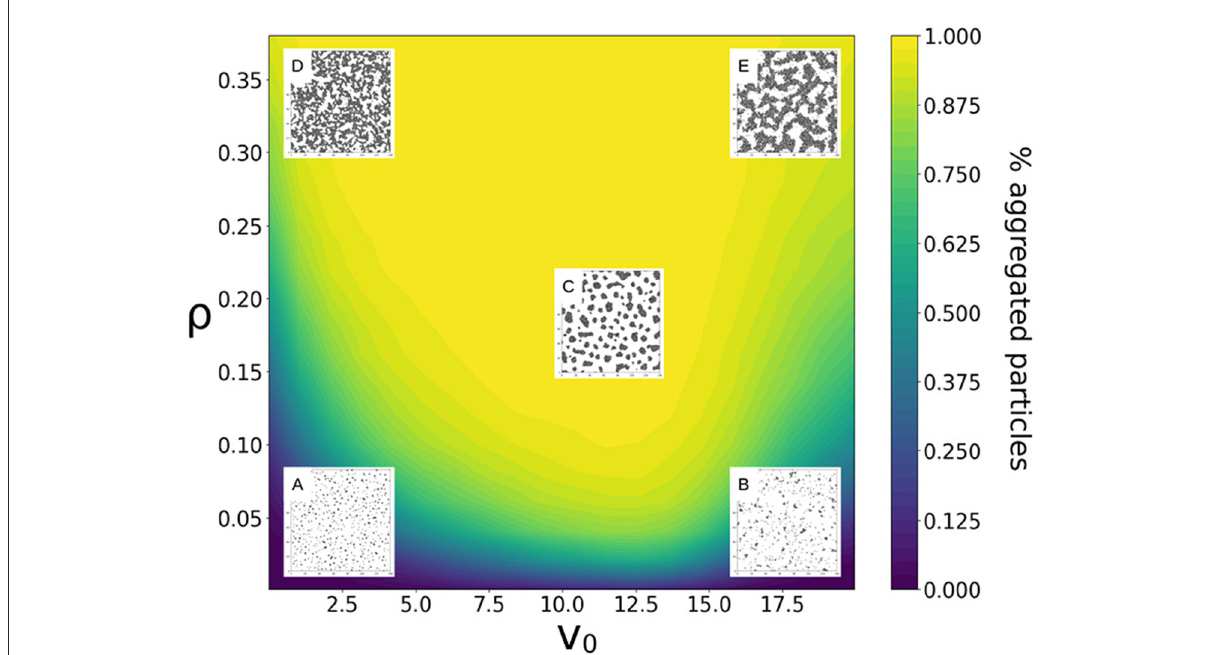
FIGURE2 Finite-time state diagram for a population of identical particles of speed v 0 and packing fraction ρ . The fraction of aggregated particles at the end of the simulation ( t f 100) is illustrated as a heatmap, indicating that the highest fraction of aggregated particles is reached for intermediate = particle speeds. Overlaid, snapshots illustrate the final particle distribution for five cases ( A : v 0 ρ 0.2, D : v 0 2.5, ρ 0.35 and E : v 0 17.5, ρ 0.35), whose aggregation dynamics is discussed in more detail in Supplementary Figure 1. = = = = = Fixed parameters values are those indicated in Table 1. The packing fraction was varied by changing L , keeping N